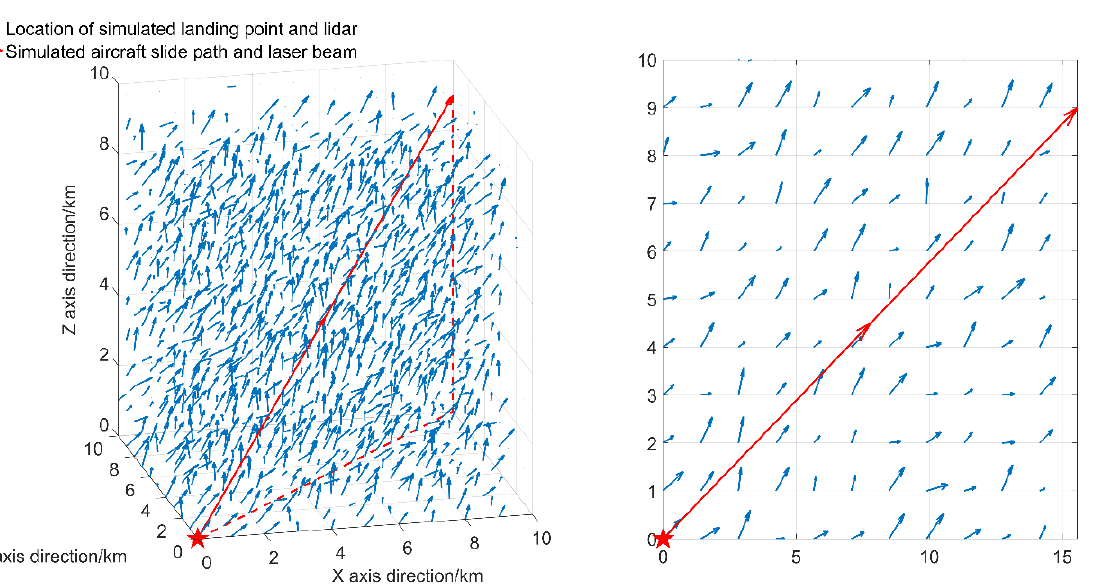
Figure 12. The left figure is the simulated turbulent wind field in the 3-D coordinate system; the right figure is the profile view of the simulated turbulent wind field.